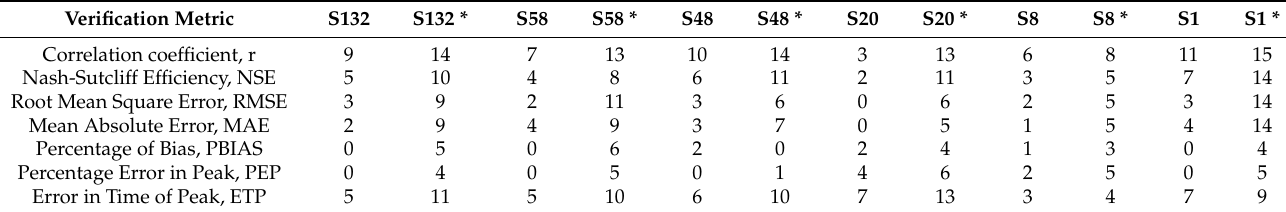
Table 6. Model scores were calculated for six configurations of both reference and calibration scenarios. A model score can range from 0 to 15, and a high score indicates a relatively better performing configuration. The label of a column without and with asterisk (*) corresponds to streamflow simulations of reference and calibration scenarios, respectively. Verification Metric Correlation coefficient,